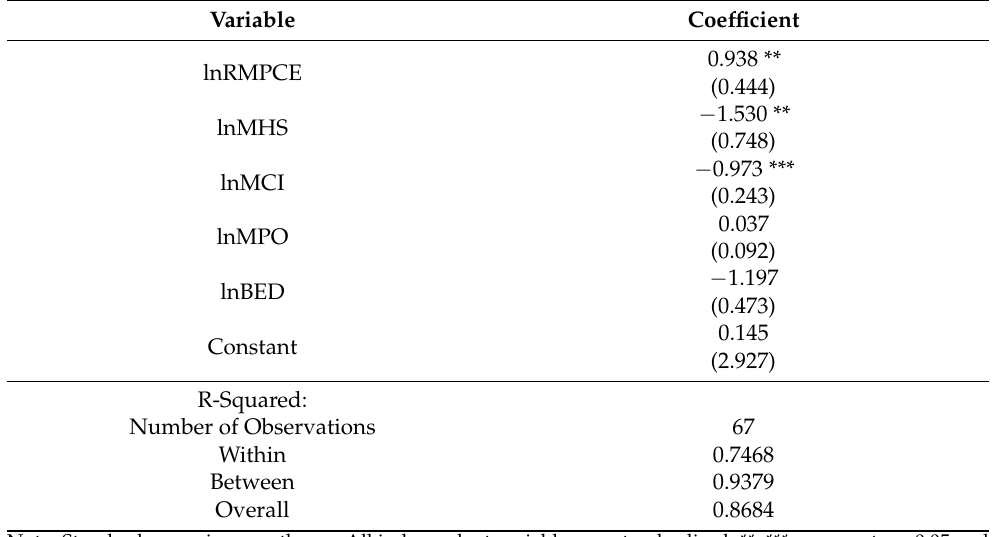
Table 3. Fixed-Effects Model